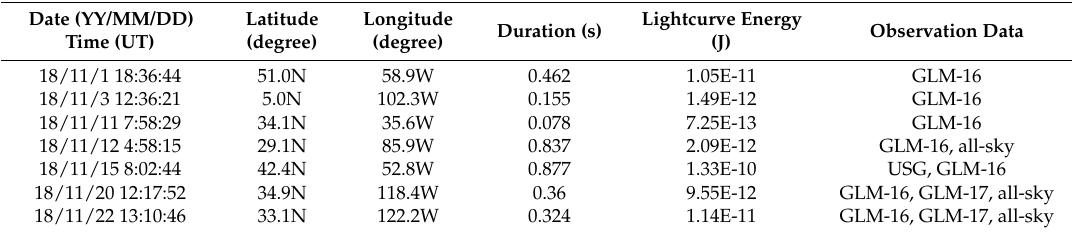
Table 3. Bolide extraction algorithm performance in November 2018. If more than one observation data entry is shown, the bolide can be considered confirmed. The entry “all-sky” in the Observation Data column refers to ground based camera observations of that bolide.